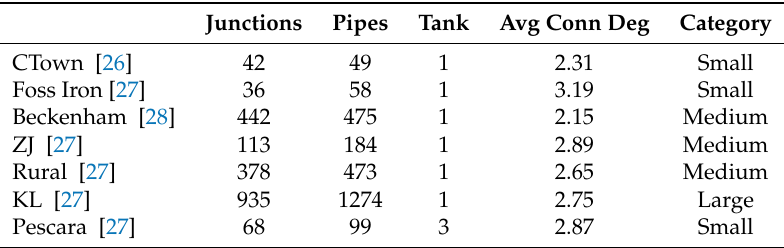
Table 2. Water distribution networks (WDNs) used in experiments.